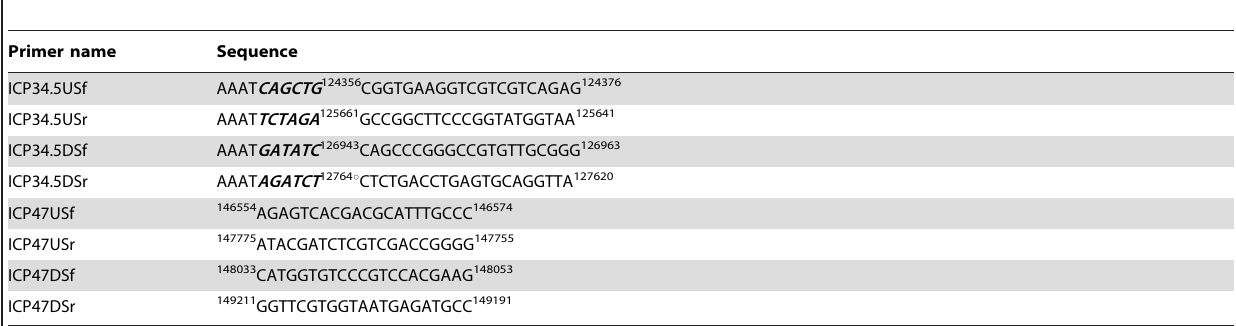
Table1. The primers used for the construction of pH2d34.5 and pdICP47H2 are shown, and the genome coordinates for the genomic sequences are